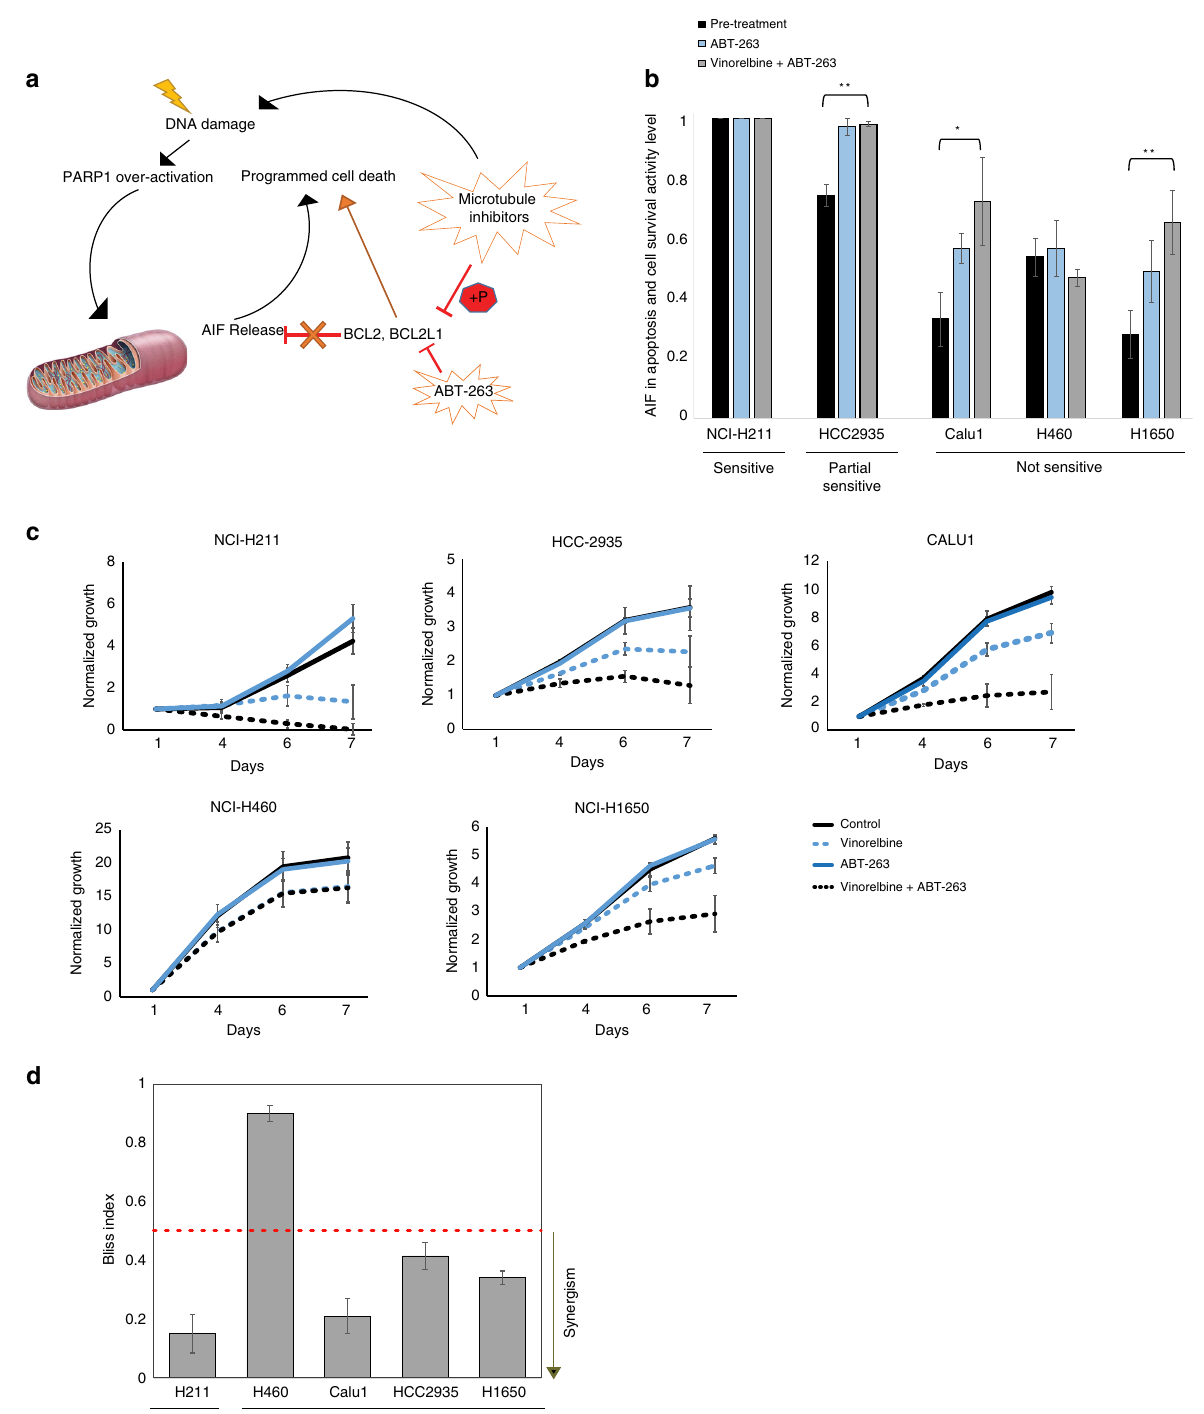
Fig. 4 BCL-XL inhibition elevates AIF pathway levels resulting in a synergistic activity with MTIs. a Cartoon depicting the ‘ AIF in apoptosis and cell- survival pathway ’ with ABT-263 and MTI activity. b AIF pathway activity levels calculated from qRT-PCR in lung cancer cell lines before treatment (black bars), after treatment with ABT-263 (blue bars), and after treatment with a combination of vinorelbine and ABT-263 (gray bars). H211 was identi fi ed as sensitive, and the other four cell lines as not sensitive. Error bars represent the standard deviation. P -values were generated using Mann – Whitney U -test. c Relative growth of lung cancer cell lines over a 7-day period with no treatment (solid black line), vinorelbine (dotted blue line), ABT-263 (solid blue line), and a combination of vinorelbine and ABT-263 (dotted black line). Error bars represent the standard deviation. d Bliss analysis of drug synergy in cell lines treated with vinorelbine plus ABT-263. Bliss index < 0.5 represents synergism. Error bars represent the standard deviation. See also Supplementary Fig.